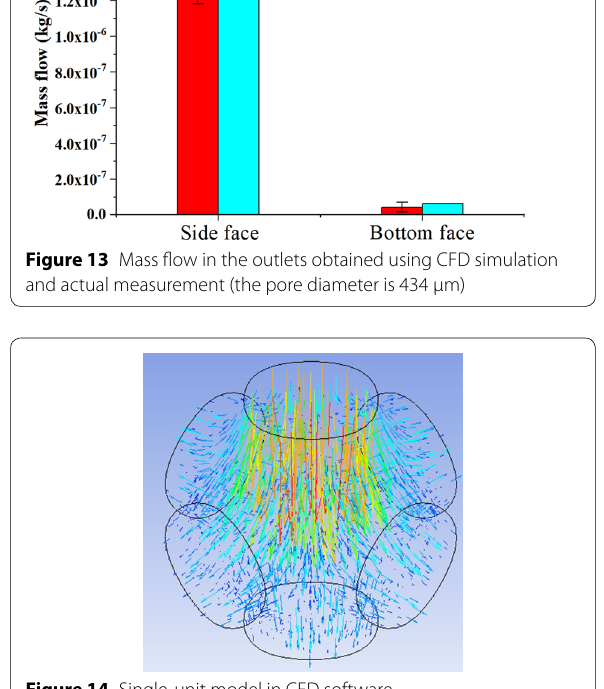
Figure 14 Single-unit model in CFD software